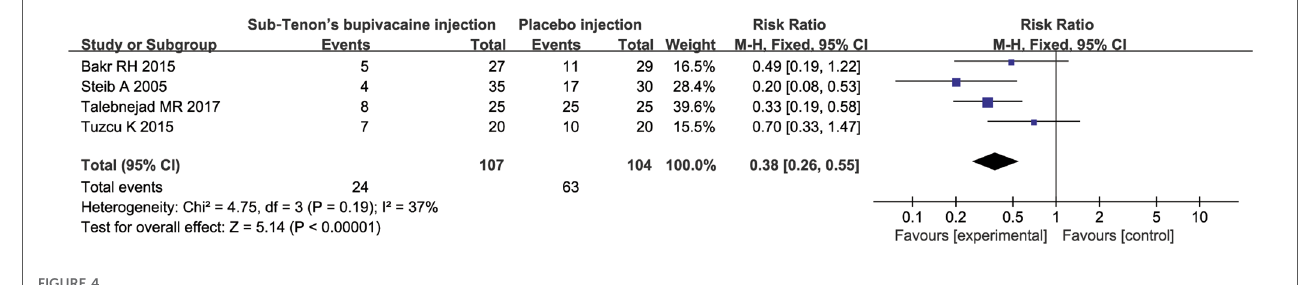
FIGURE 4 OCR occurrence comparison.